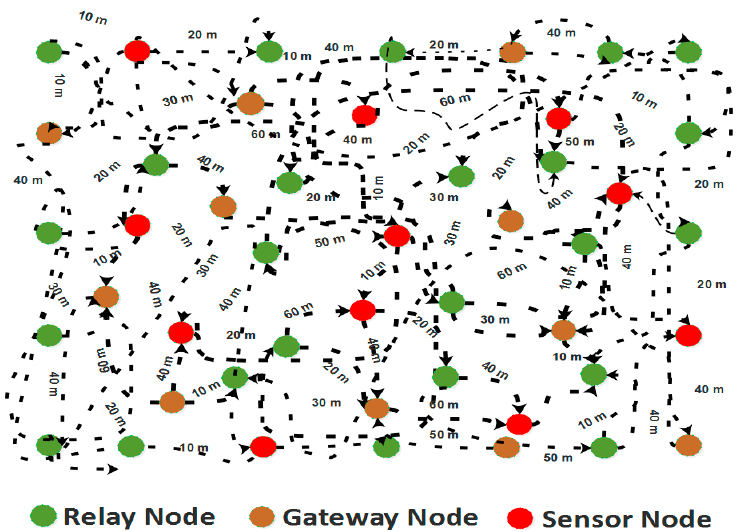
Figure 2. Nodes are randomly deployed in the IoUTs scenario without applying the ROBINA al- gorithm (especially when the path is not established).